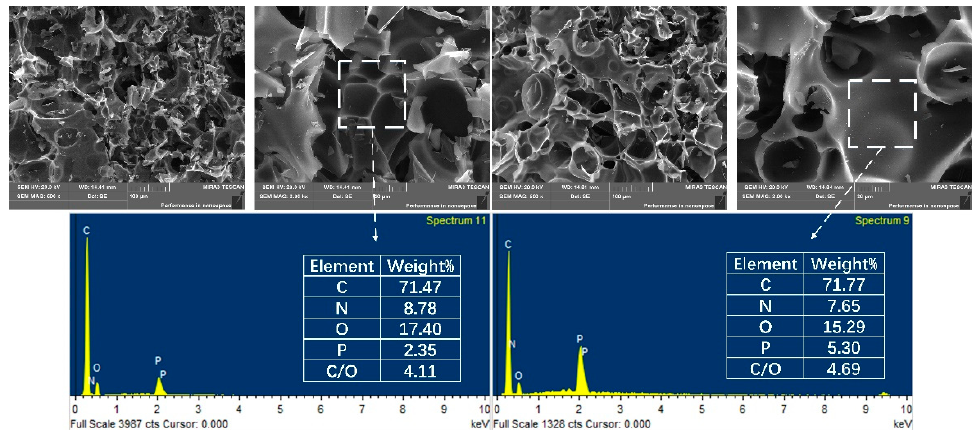
Figure 12. SEM images and EDS maps of the char residues of EP/10APP and EP/10DDP obtained after the cone calorimeter test.